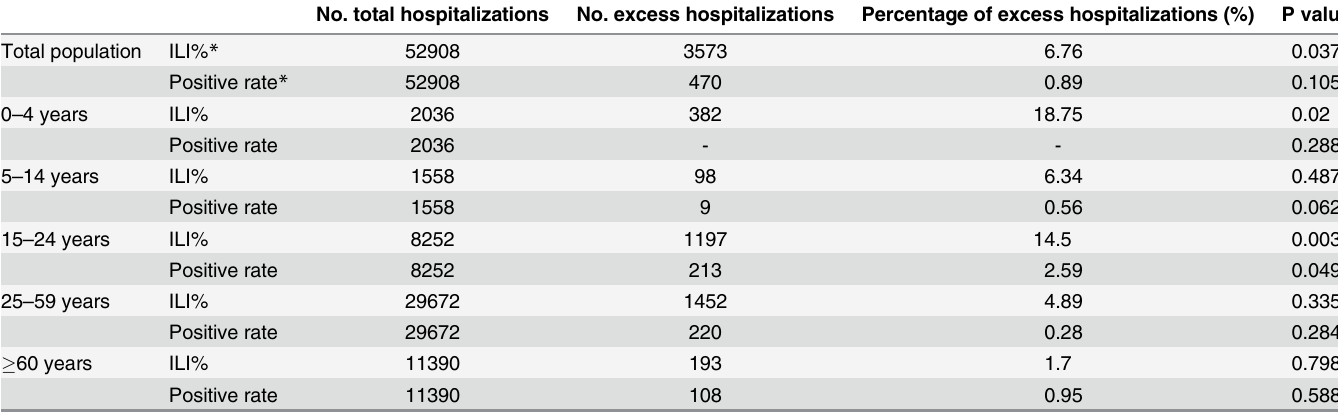
Table 4. Impact of influenza-like illness and influenza on hospitalizations.